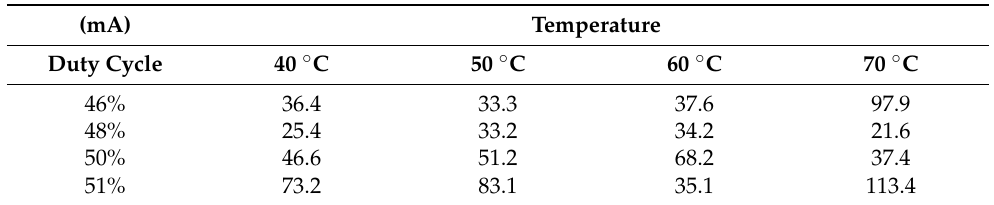
Table 5. Mean absolute error (in mA) of the inductor current for different duty cycles and tempera- tures for the differential equation simulations.